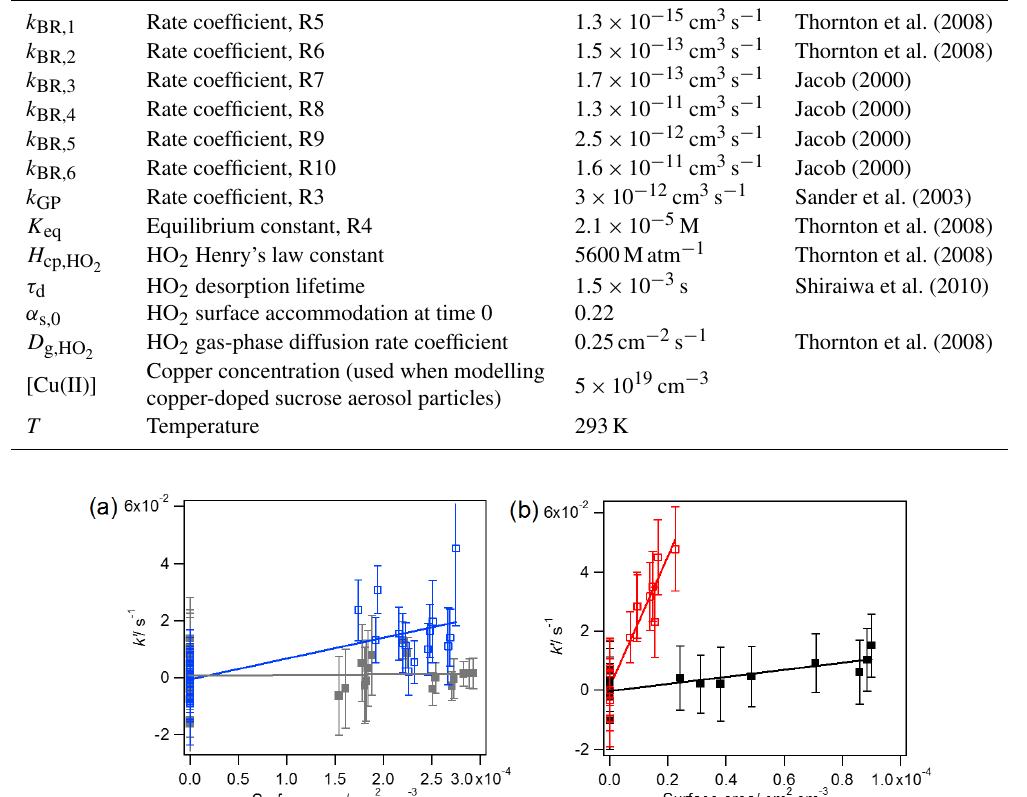
Table 1. The parameters used in the KM-SUB HO 2 uptake model over all relative humidities. Parameter